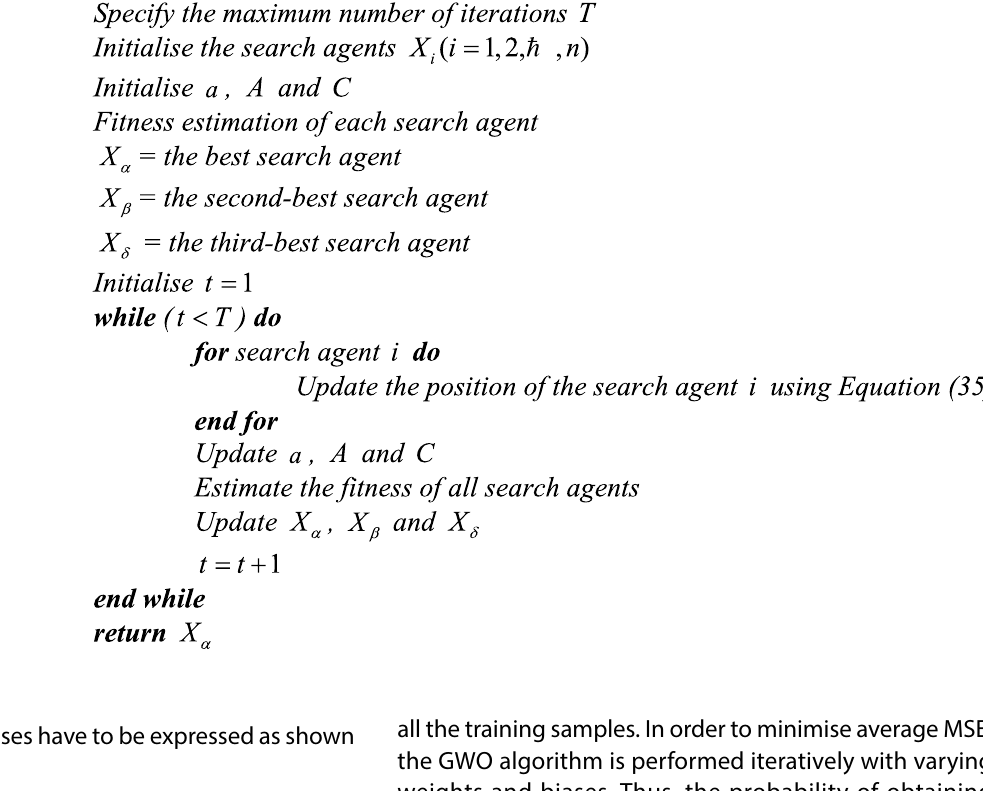
Fig. 2 GWO Pseudo